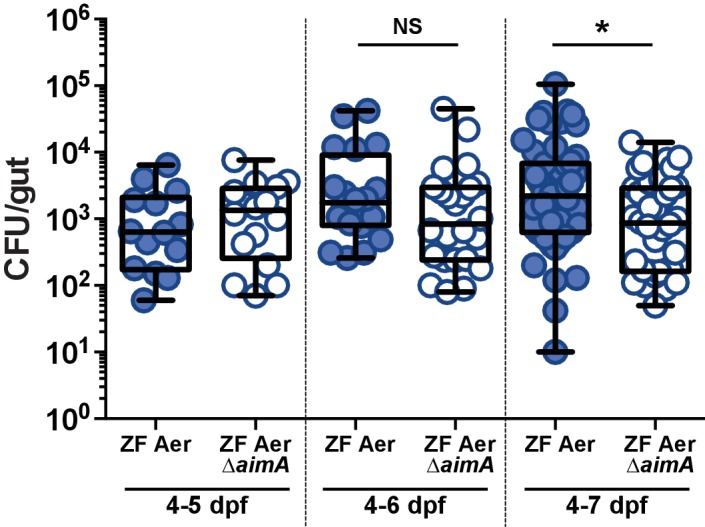
ZF Aer ΔAimA suffers the greatest colonization defect seven dpf.Comparison of WT ZF Aeromonas (ZOR001) and ZF Aer ΔAimA colonizing the zebrafish intestine for 24 hr (4–5 dpf), 48 hr (4–6 dpf), or 72 hr (4–7 dpf). *p<0.05, Students T test. N > 14, from at least two independent experiments.10.7554/eLife.37172.024Figure 5—figure supplement 2—source data 1.ZF Aer DAimA suffers the greatest colonization defect 7 dpf.